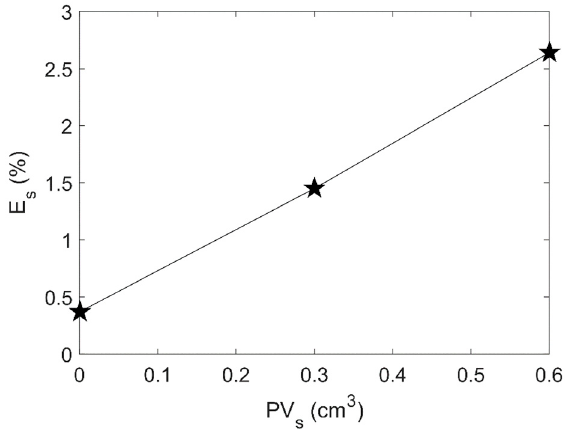
Figure 6. Linear relationship between E s (%) and PV s (cm 3 ).